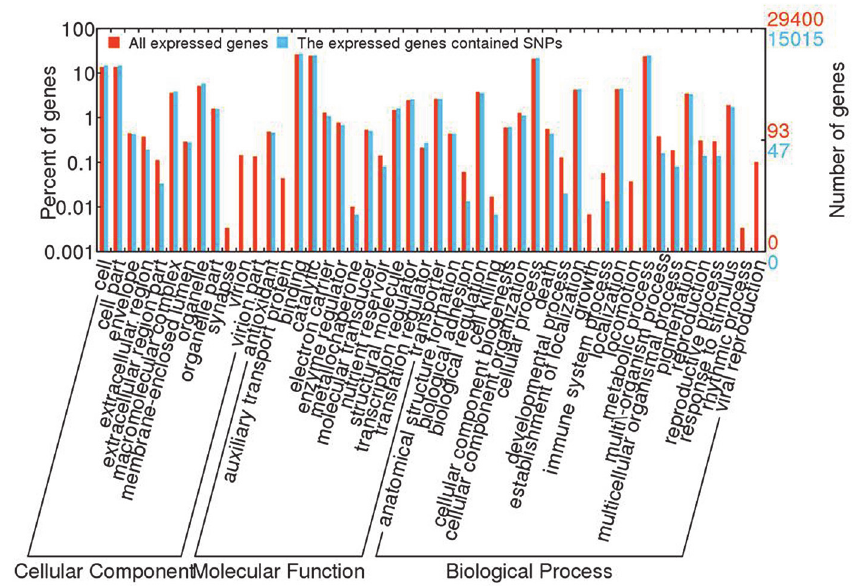
Fig 4. GO analysis of all the expressed genes in lotus and the genes contained SNP.